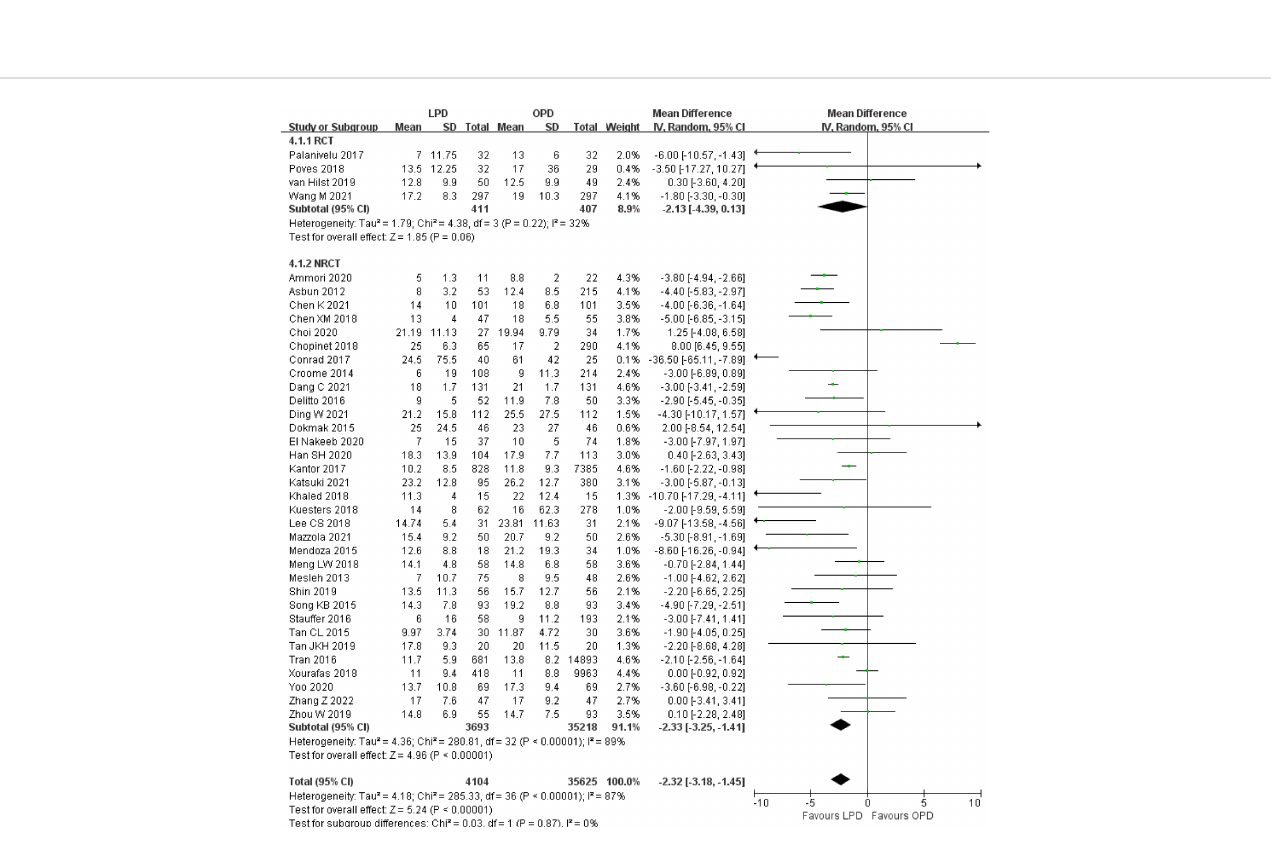
FIGURE 4 Forest plot of comparison between LPD and OPD on hospital stay. LPD, laparoscopic pancreaticoduodenectom; OPD, open